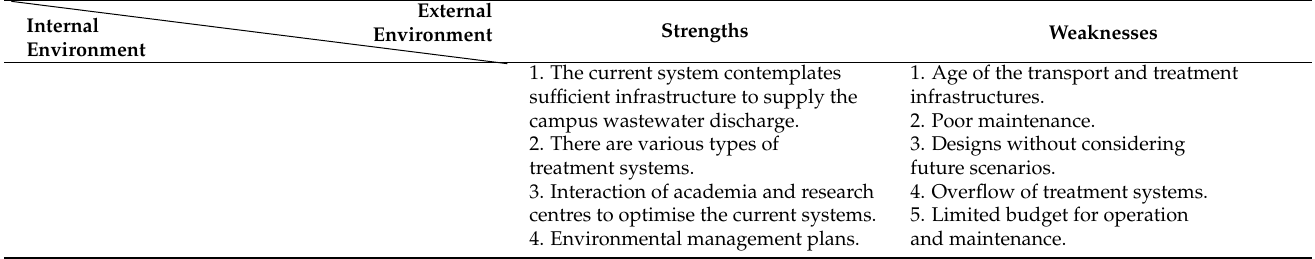
Table 19. Strengths, weaknesses, opportunities, and threats (SWOT) matrix analysis of current and proposed sewer system. The SWOT combines the internal environment (strengths and weaknesses) identified by numbers 1 to 4 and the external environment (opportunities and threats) identified by letters (a) to